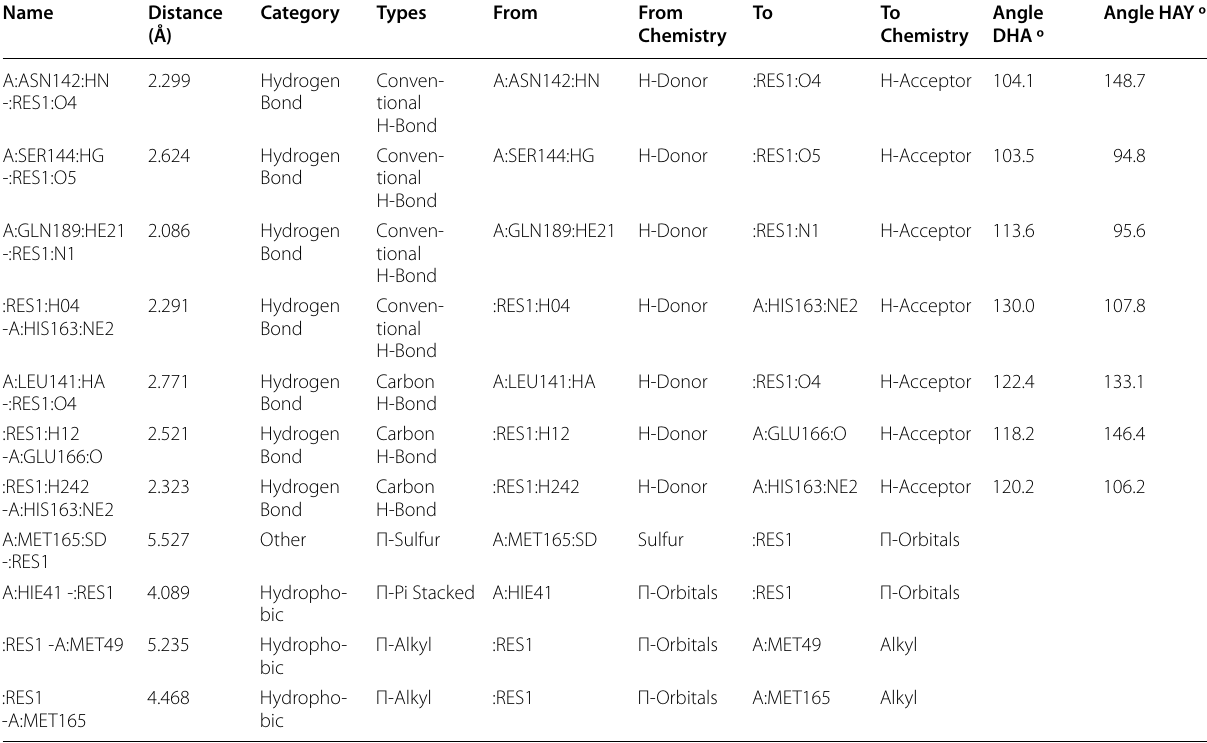
Table 1 Interaction types with surrounding amino acids of SARS CoV 2 Main Protease (PDB ID: 6xbh) with REF-IN Name Distance